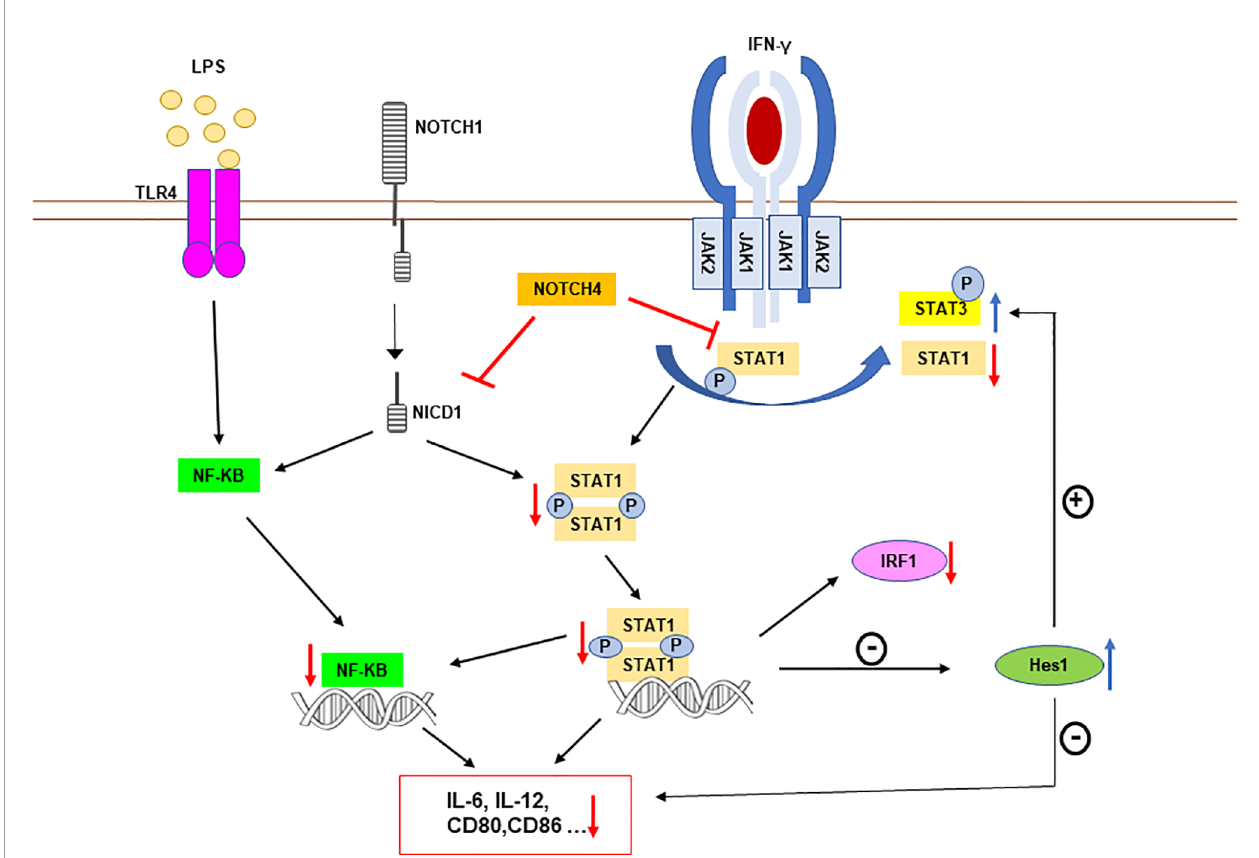
FIGURE 9 | Schematic representation of NOTCH4 receptor interference with TLR4 and IFN g receptor signaling in proin fl ammatory activated macrophages. NOTCH4 diminishes STAT1 phosphorylation after IFN- g receptor activation. This lower STAT1 activation decreases the expression of STAT1-dependent genes, including IRF1, but increases the expression of HES1, which is normally repressed by STAT1 (39). HES1 exerts an anti-in fl ammatory action by inhibiting the expression of genes such as those for IL-6 or IL-12 (8). Moreover, enhanced levels of HES1 could facilitate STAT3 phosphorylation and activation, increasing the expression of anti- in fl ammatory genes, such as that for IL-10 (7). NOTCH4 also inhibits NF- k B-dependent transcription. This effect is mediated, at least in part, by the lower activation of STAT1, that normally cooperates with NF- k B increasing its transcriptional activity in some pro-in fl ammatory gene promoters, such as those of IL-6 or IL-12 (36). Because of the lower STAT1 and NF- k B activation mediated by NOTCH4, and of the elevated levels of the repressor HES1, the expression of STAT1 and NF- k B target genes, such as IL-6, IL-12 or CD80 among others, is diminished. The blue arrows mark increased phosphorylation or expression induced by NOTCH4, whereas red arrows indicate repression by